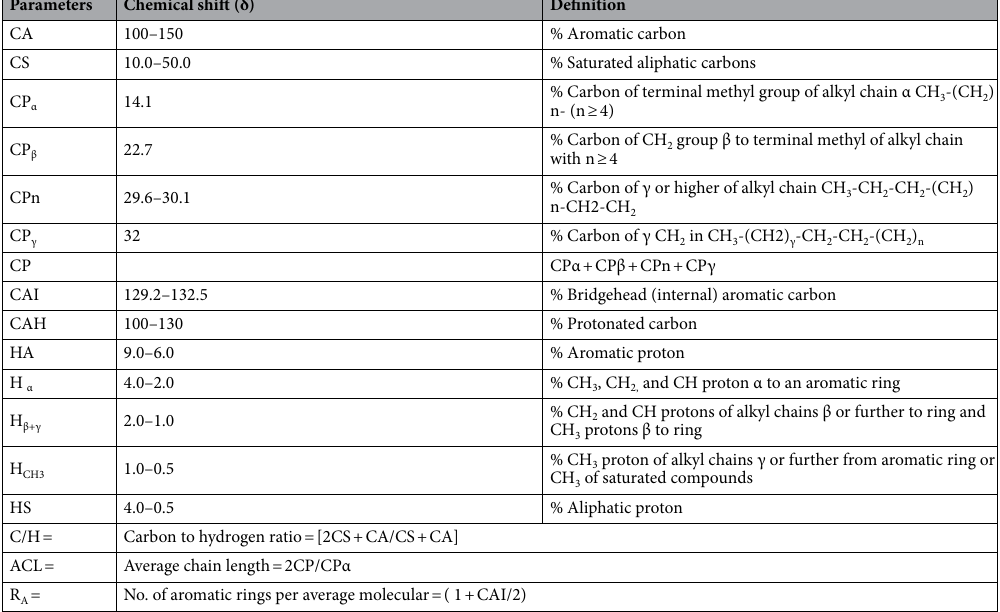
Table 3. Definitions of 1 H and 13 C NMR chemical shifts for